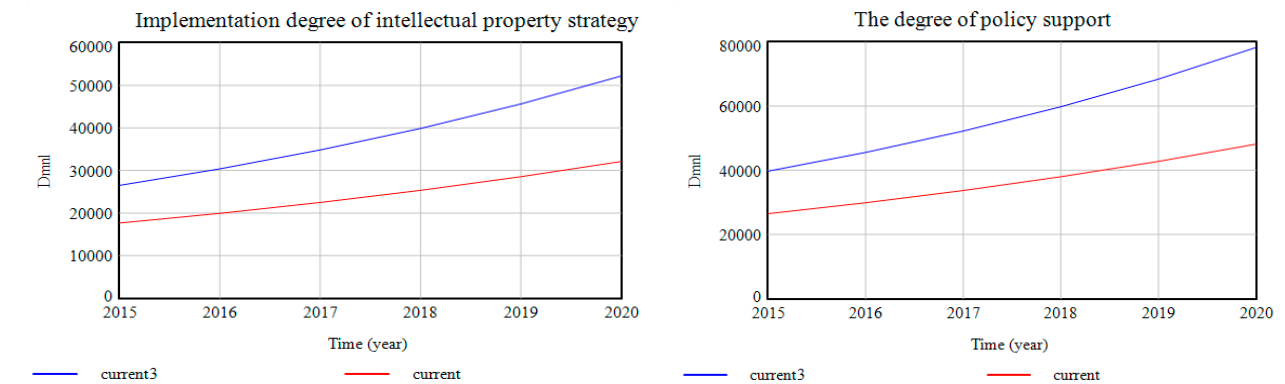
Figure 4. The impact of enhanced policy and intellectual property strategy on the regional economy. (Note: In the above Figure 2, the horizontal axis represents the year, and the vertical axis represents the quantity).